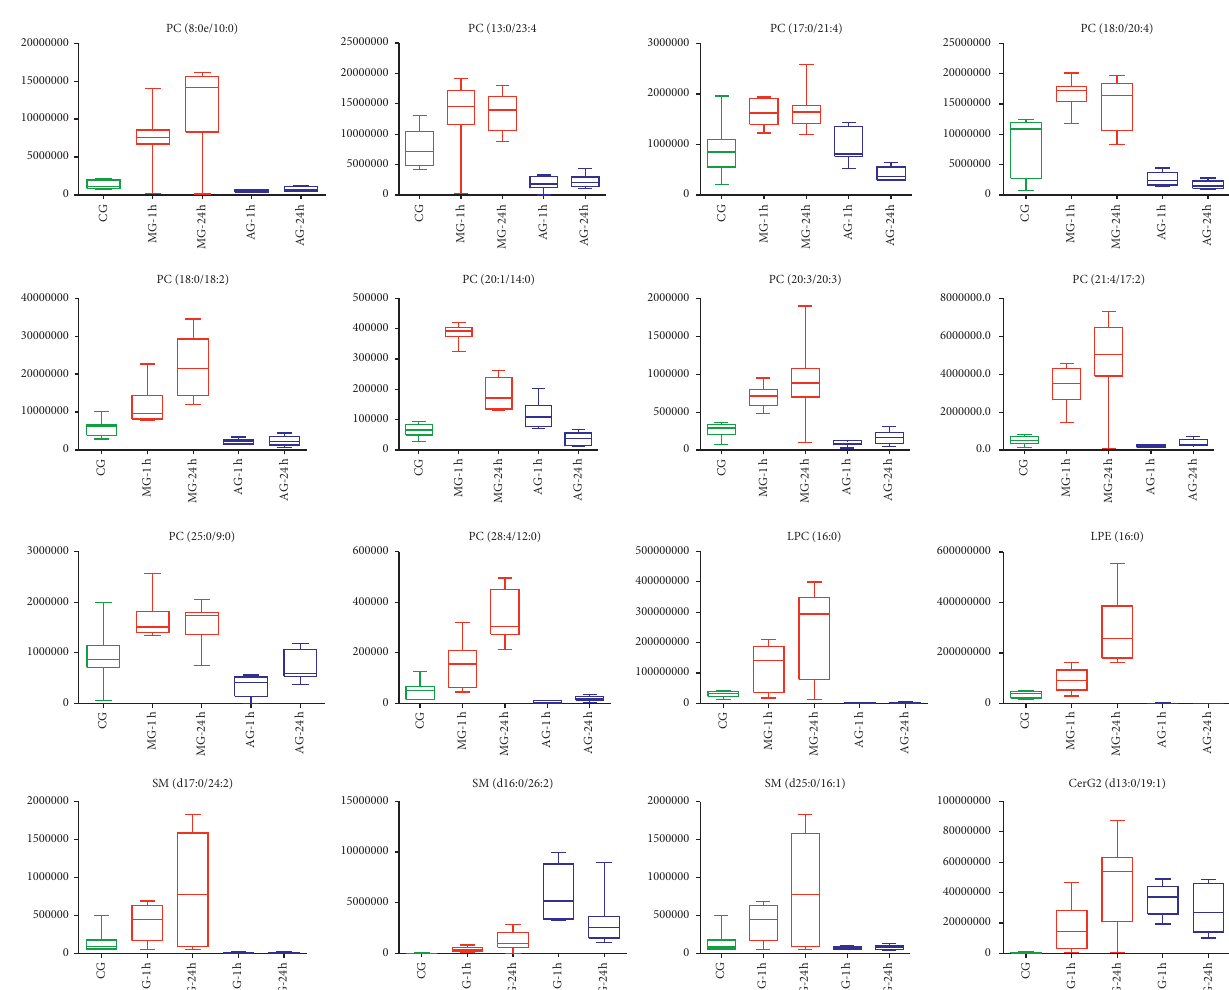
Figure 4: Box plot analysis for important lipid biomarkers by the regulation of